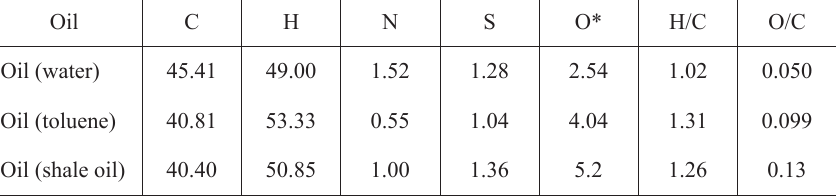
Table 7. Elemental analyses of the oils obtained from RH, atomic % Oil C H N